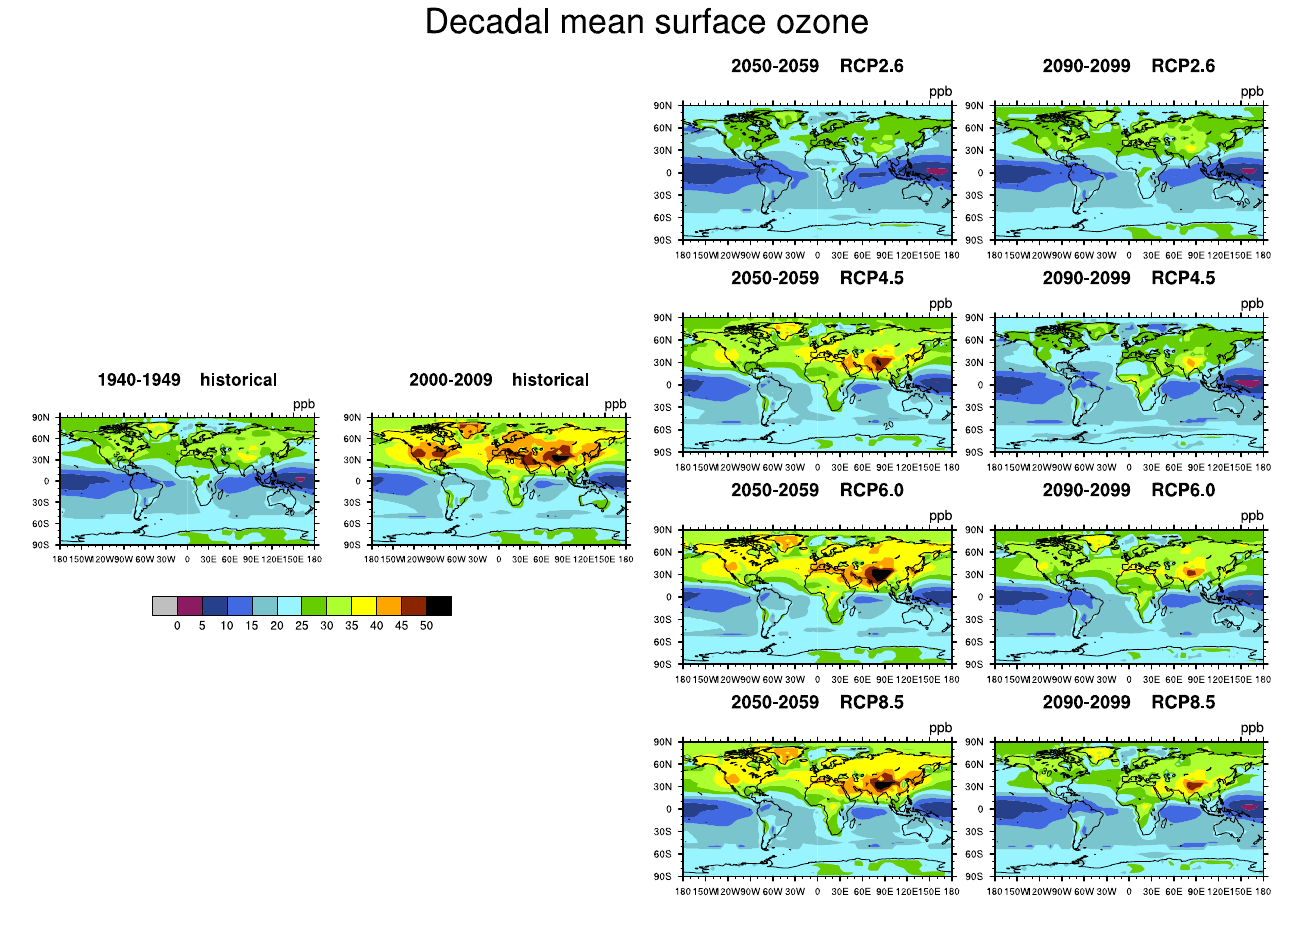
Fig. 10. As Fig. 9, but for decadal mean surface